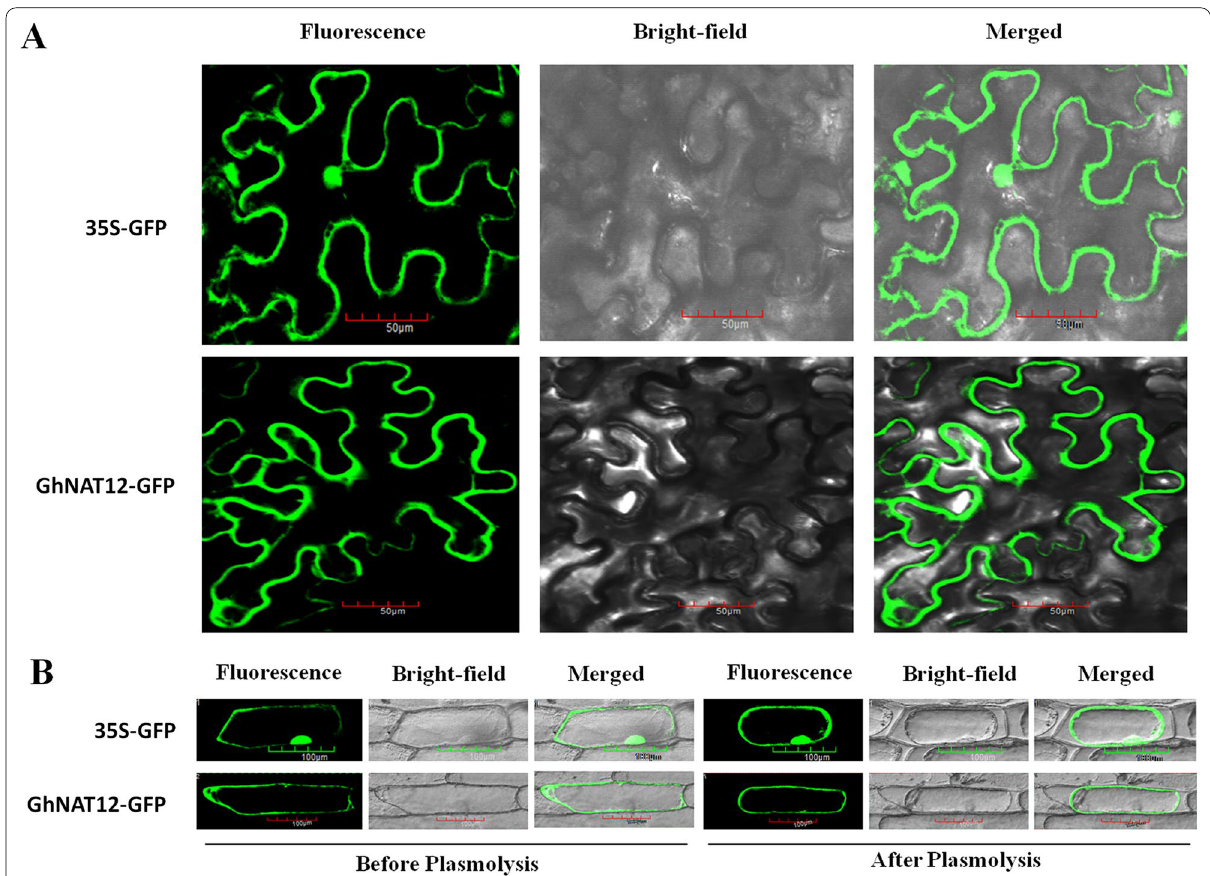
Fig. 9 Subcellular localization of GhNAT12. A The GhNAT12-GFP signals were localized to the plasma membrane. B GhNAT12-GFP and GFP signals on the plasmolysis of onion